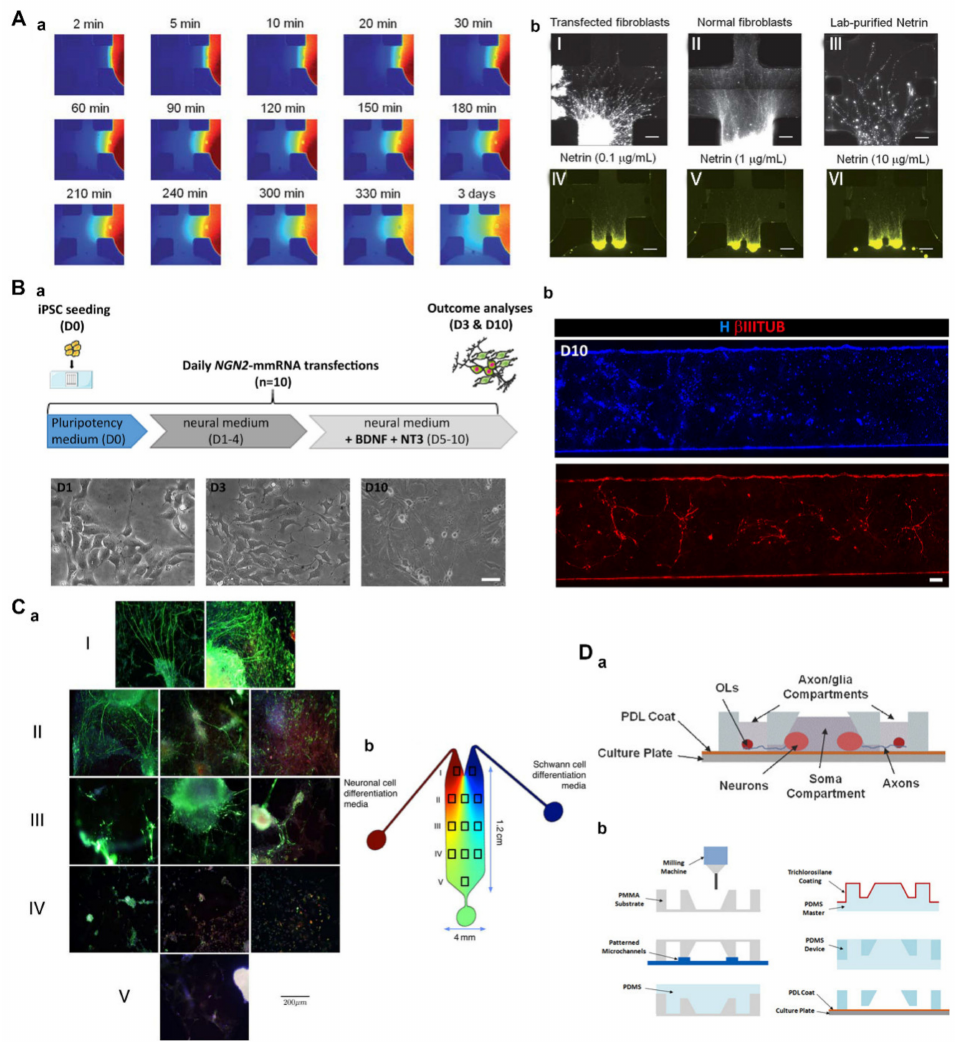
Figure 4. ( A ) A microfluidic device to study neurite guidance under chemogradients. Typical time- dependent snapshots of the gradient obtained with a 40 kDa FITC-dextran in the device ( a ). Neurite guidance of hippocampal neurons by chemoattractants ( b ). ( B ) NGN2 mRNA-based transcriptional programming. The NGN2-mediated transcriptional programming experiment of human-derived neural stem cells (hiPSCs) in microscale ( a ). Representative image of a single microfluidic channel of hiPSCs of NGN2 mmRNA transcriptional programming ( b ). ( C ) Differentiation of mouse embryonic stem cells (mESC) into neuron-like cells and Schwann cell-like cells in a microfluidic device. Pho- tomicrographs ( a ) of the areas of the device, depicted as boxes in the cartoon ( b ). The top three rows ( I – III ) show significant neuronal differentiation and the directional outgrowth of neurites toward the “Schwann cell” sectors. The bottom two rows ( IV , V ) show no significant differentiation into any specific lineage. ( D ) A multi-compartment co-culture microfluidic platform. Schematic of the high-throughput microfluidic multi-compartment CNS neuron co-culture platform ( a ). Schematic of fabrication steps for the multi-compartment PDMS microfluidic device ( b ). ( A ) Adapted with permission from Ref. [91]. Copyright 2011, the Royal of Society of Chemistry; ( B ) Adapted with permission from Ref. [92]. Copyright 2021, Frontiers Media S.A.; ( C ) Adapted with permission from Ref. [94]. Copyright 2016, Wiley Periodicals, Inc.; ( D ) Adapted with permission from Ref. [95]. Copyright 2009, MYJoVE